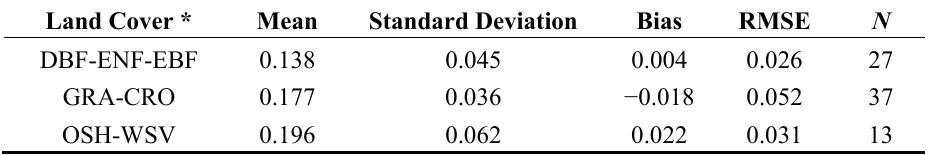
Figure 7. Relationship of relative estimation error in shortwave albedo and sun-sensor-target geometries. Table 3. Albedo estimation accuracy for different land cover types at Ameriflux sites. Land Cover